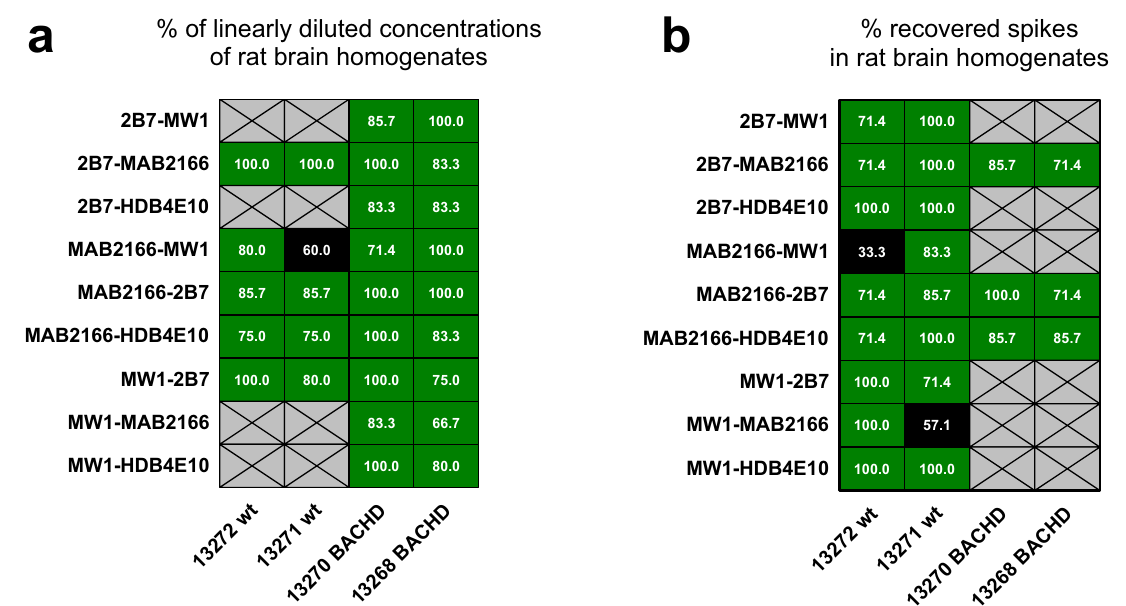
Figure 4. Dilution linearity and spike recovery in wild type and BACHD rat brain homogenates. Grey crossed cells represent not tested antibody pairs, black cells are antibody pairs that did not meet the 67% acceptance criteria (see text), green cells show antibody pairs with achieved dilution linearity and/or spike recovery. ( a ) Two wild type rats(13272 and 13271) and two BACHD rats (13270 and 13266) brain homogenates were diluted starting 1.3 µg/ml of total protein for the 2B7-MW1 assay and from 6.7 µg/ml of total protein for all other antibody pairs for 7 dilution points. Each dilution curve was assayed via SMC using the antibody pair reported on the x-axis. The percentage of the dilution points within ± 20% RE% is reported in each cell of the heat-map. The acceptance threshold is 66.7%; all passed conditions are coloured in green. All data for each matrix and assay is reported in the supplementary figure S-4 along with an example of the dilution linearity calculations. The Dilution linearity of wild type homogenates for the 2B7-MW1, 2B7-HDB4E10, MW1-MAB2166, and MW1-HDB4E10 are not reported as most dilution points were below the LLoQ for these assays. ( b ) The same four rat brain samples were spiked with a serial dilution of the recombinant FL HTT Q46 and assayed via SMC using the antibody pair reported on the x-axis. The percentage of the recovered spikes, within one matrix, are in each cell of the heat-map. The acceptance threshold is 66.7%; all passed conditions are coloured in green. All data for each matrix and assays are reported in the supplementary figure S-5. The spike recovery test was not run in BACHD rat homogenates with assays including the MW1 antibody as the signal of the endogenous analyte was too